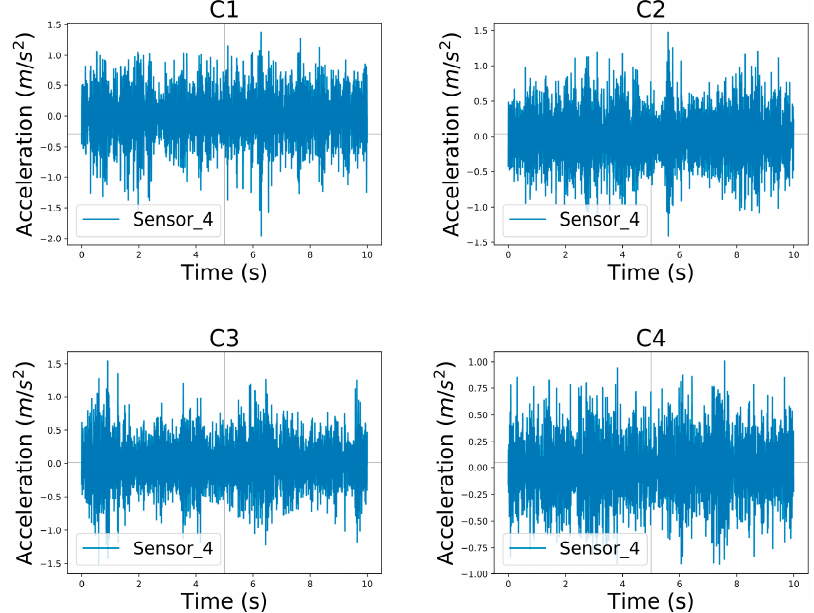
Figure 4. The acceleration curves on the three-story building structure.